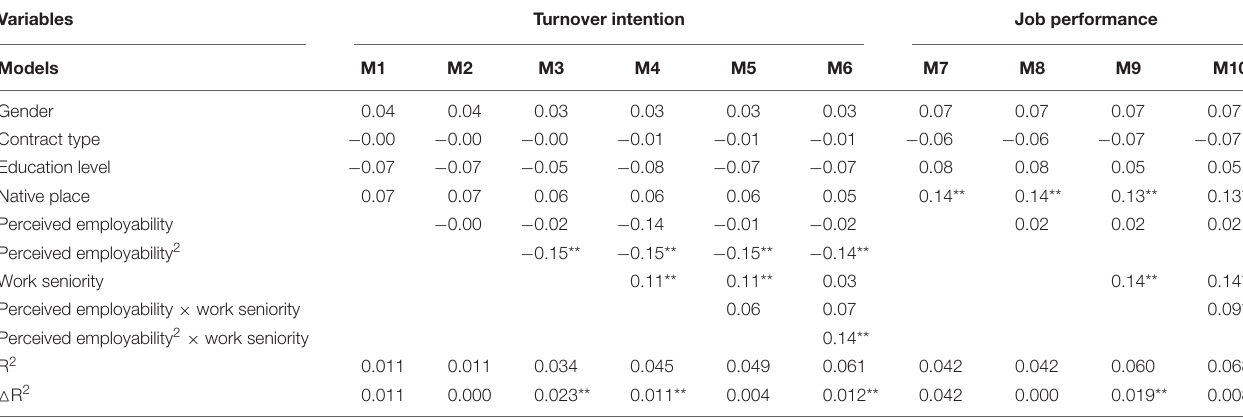
TABLE 2 | Regression results for turnover intention and job performance ( N = 623).